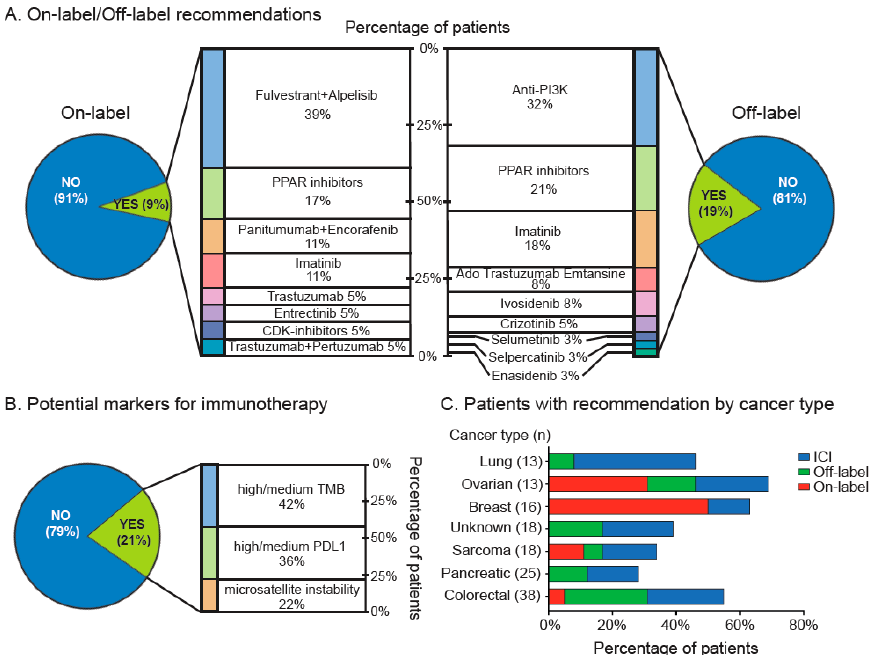
Figure 3. Clinical actionability for targeted therapies. ( A ) On-label (left panel) and off-label (right panel) and ( B ) immune checkpoint inhibitor recommendations based in NGS/IHC profiles. ( C ) Percentages of recommendation (on-label, off-label or ICI) by cancer